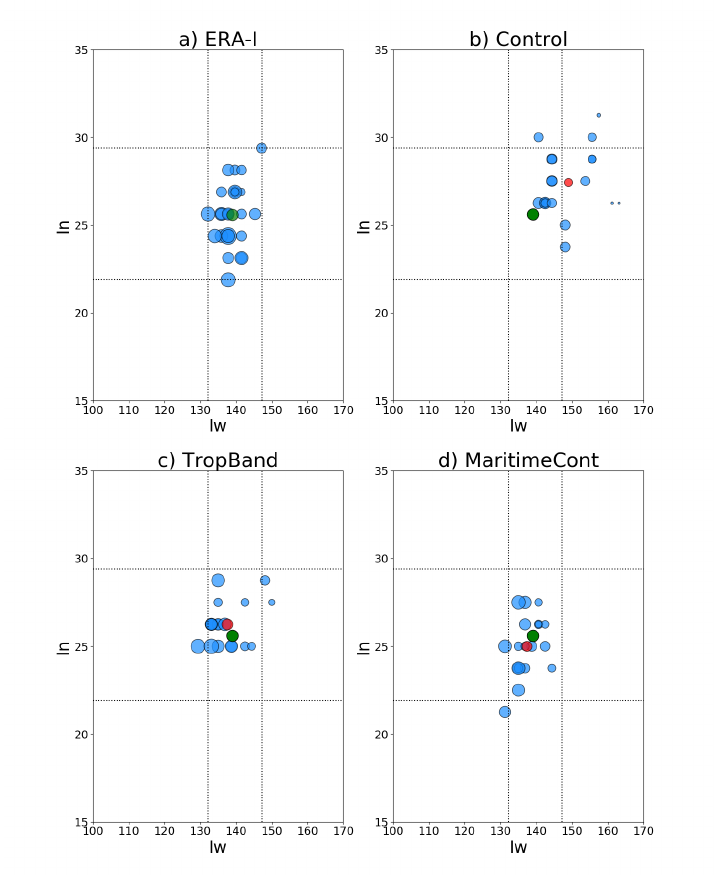
Figure 5. 1982–2007 interannual variability of June–August WPSH intensity, west extension and northern edge indices in ERA-I and AMIP-N96 nudging sensitivity experiments. Axes in the scatter plots are as follows: abscissae show values of the west extension index, I W ( ◦ E) and ordinates show values of the northern edge index, I N ( ◦ N). The radii of scatter circles are proportional to the intensity index, I IN .To facilitate comparisons between ERA-I and climate simulations, the following attributes have been added: dotted lines that indicate maximum and minimum values of I N and I W for ERA-I, and green and red dots that show, respectively, the 1982–2007 mean index value for ERA-I and for each climate simulation. Indices are shown for ( a ): ERA-I; ( b ): AMIP-N96; ( c ): tropical band and ( d ): Maritime Continent. (See top right panel in Figure 2a for definitions of the nudging